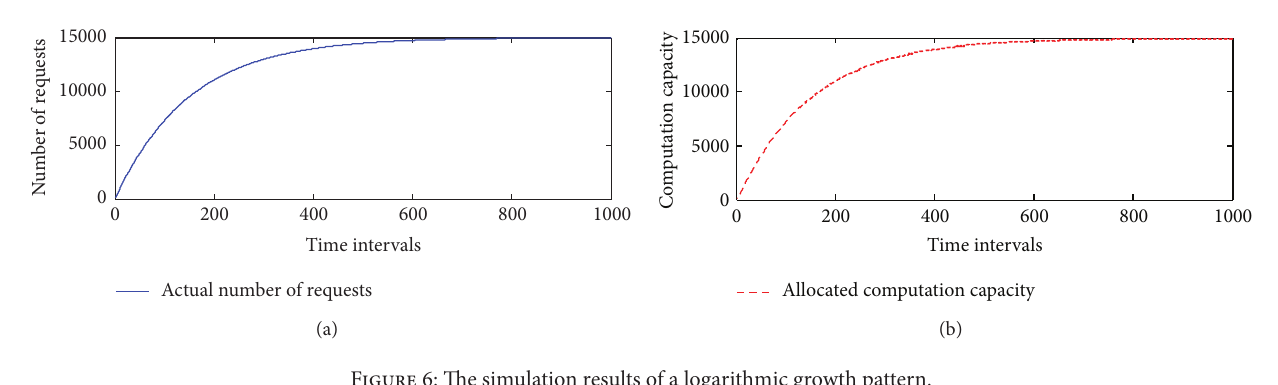
Figure 5: The simulation results of a linear pattern.